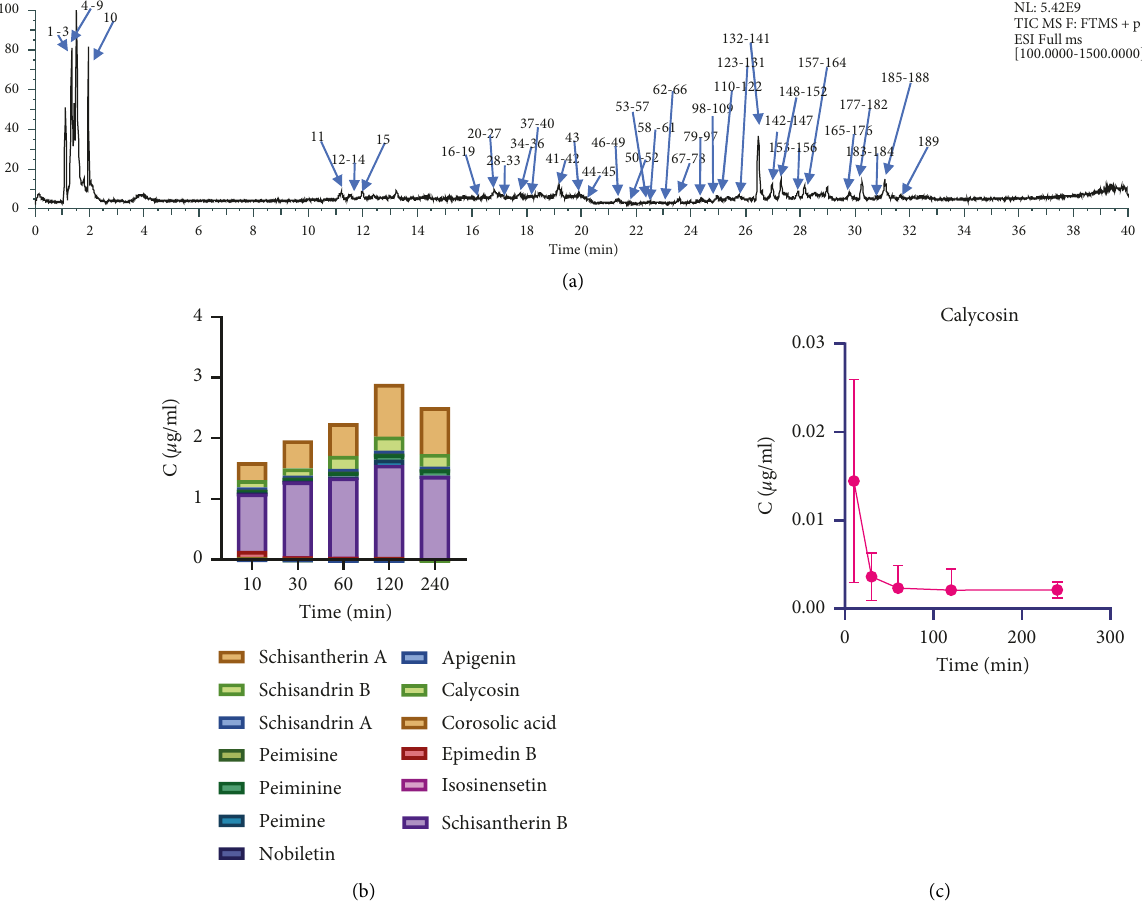
Figure 2: (a) Total ion chromatograms of BYF obtained in positive ion mode. (b) Serum concentrations of 13 components of BYF after oral administration. (c) Mean serum concentration–time profile of calycosin after the oral administration of (Bge.) Hsiao or Astragalus membranaceus (Fisch.) Bge.,